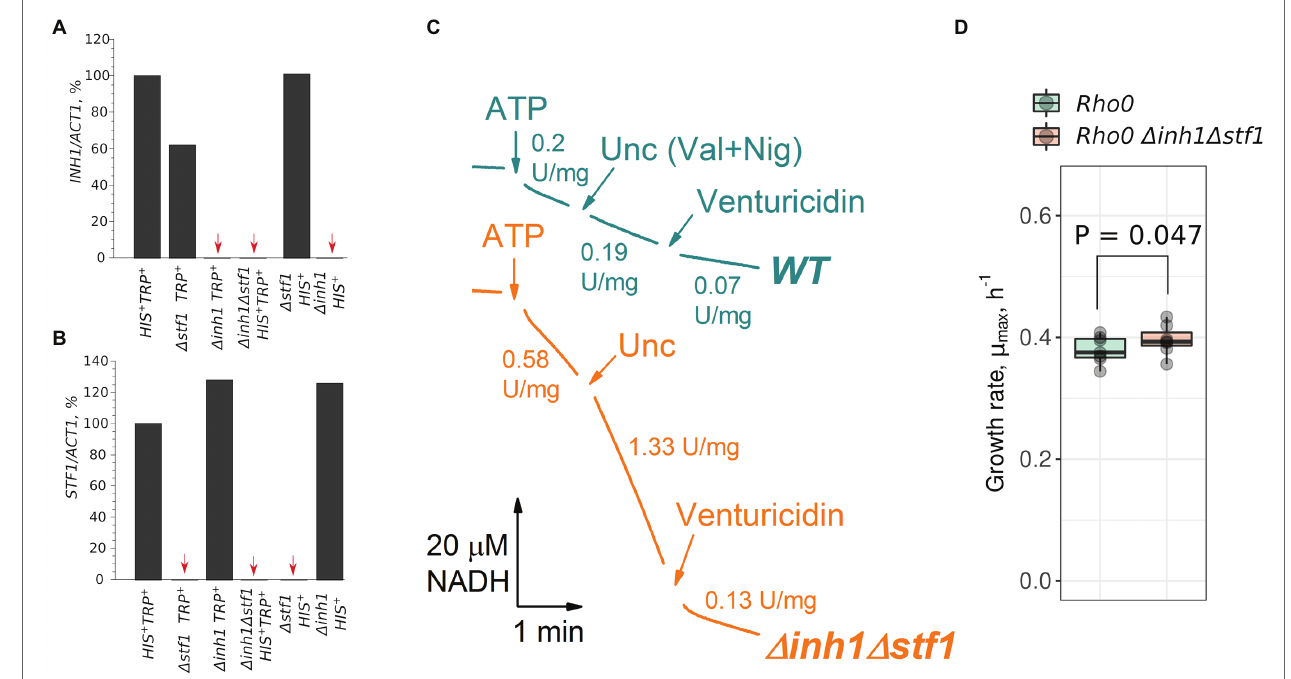
FIGURE 3 | Double deletion of INH1 and STF1 increases the rate of ATP hydrolysis by isolated mitochondria and the growth rate of cells without mitochondrial DNA (mtDNA; rho 0 ). (A,B) INH1 and STF1 mRNA levels in the control and deletion strains. All mRNA levels were normalized to the ACT1 mRNA level, and the value in control ( HIS + TRP + ) cells was set at 100%. Red arrows indicate strains with undetectable mRNA levels (single experiment); (C) ATP hydrolysis rate by mitochondria isolated from the control (WT) and Δ inh1 Δ stf1 cells. ATP hydrolysis was registered as NADH oxidation in ATP regenerating system (see Materials and Methods) in the presence of respiratory chain inhibitor myxothiazole. The reaction was started by addition of ATP to 1 mM. When indicated (Unc, Val + Nig), a mixture of valinomycin and nigericin was added to dissipate Δμ H+ .; Venturicidin was added to reveal F O F 1 -specific activity; representative curves of two independent mitochondrial isolations; (D) Growth rates ( μ max ) of rho 0 cells lacking mtDNA derived from the control (WT) and Δ inh1 Δ stf1 strains in rich medium supplemented with glucose (YPD). p value was calculated according to paired Wilcoxon signed-rank